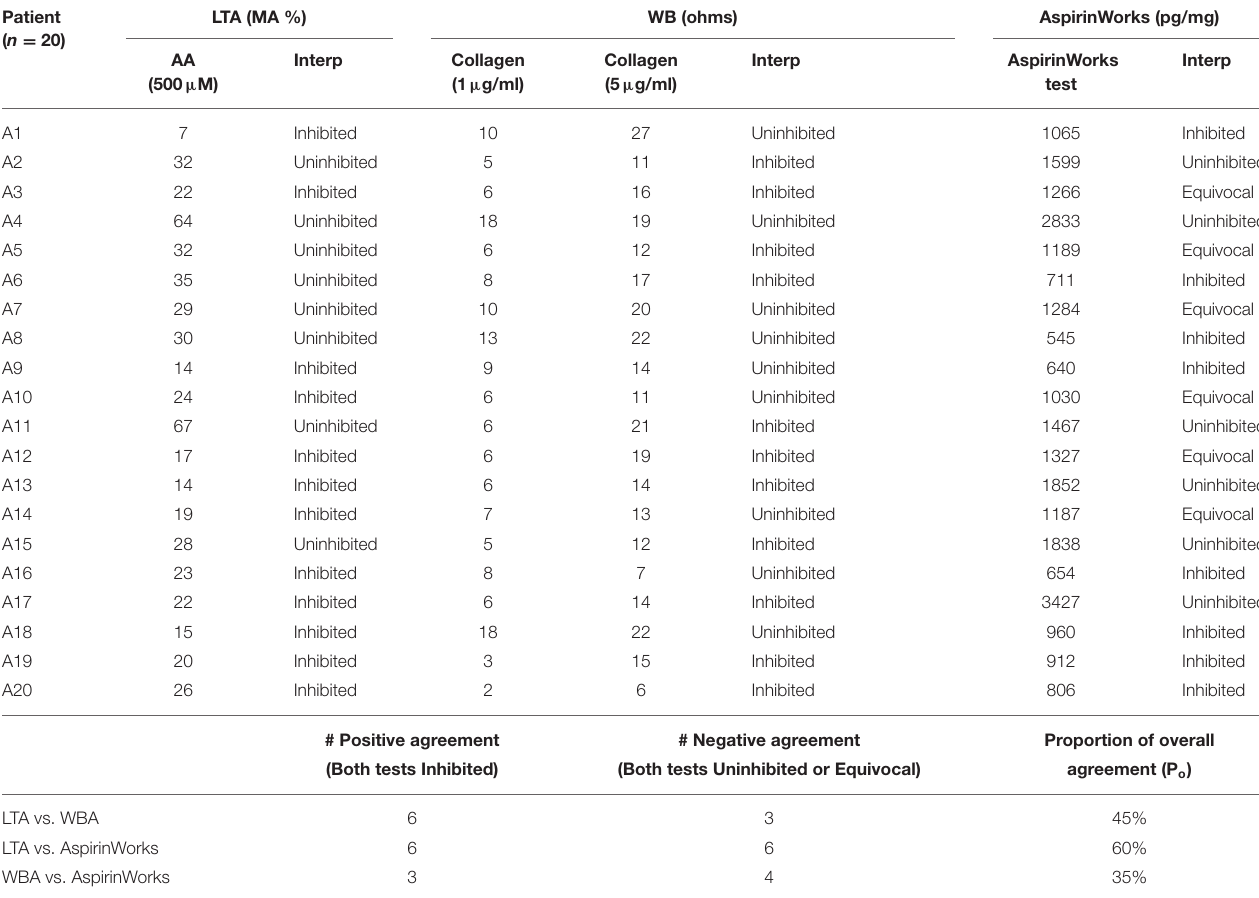
TABLE 2 | Summary of ASA-response results compared across three testing platforms. Patient ( n =